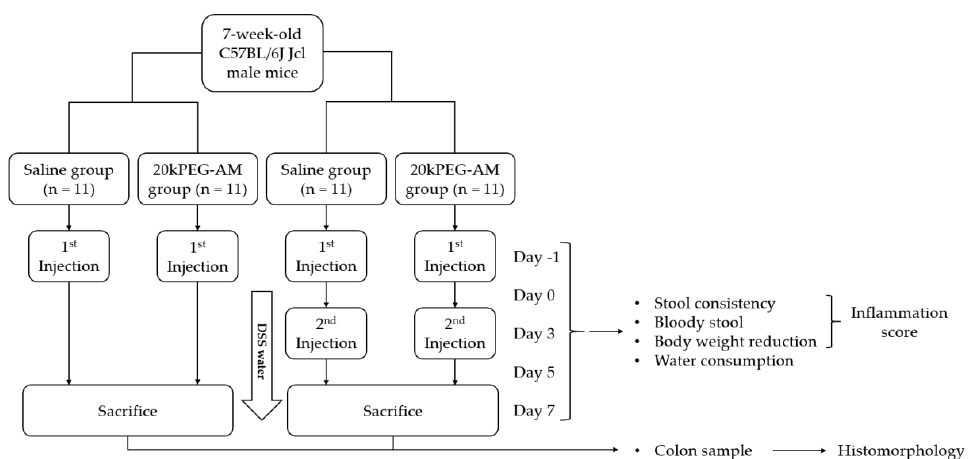
Figure 4. Flow chart of an animal experiment that evaluated an anti-colitis effect of 20kPEG-AM. Single and double injection protocols were performed with saline as a control. DSS water was given ad libitum from days 0 to 7. Mice were checked for stool consistency, bloody stool, bodyweight rection, and water consumption on days −1, 0, 3, 5, and 7.